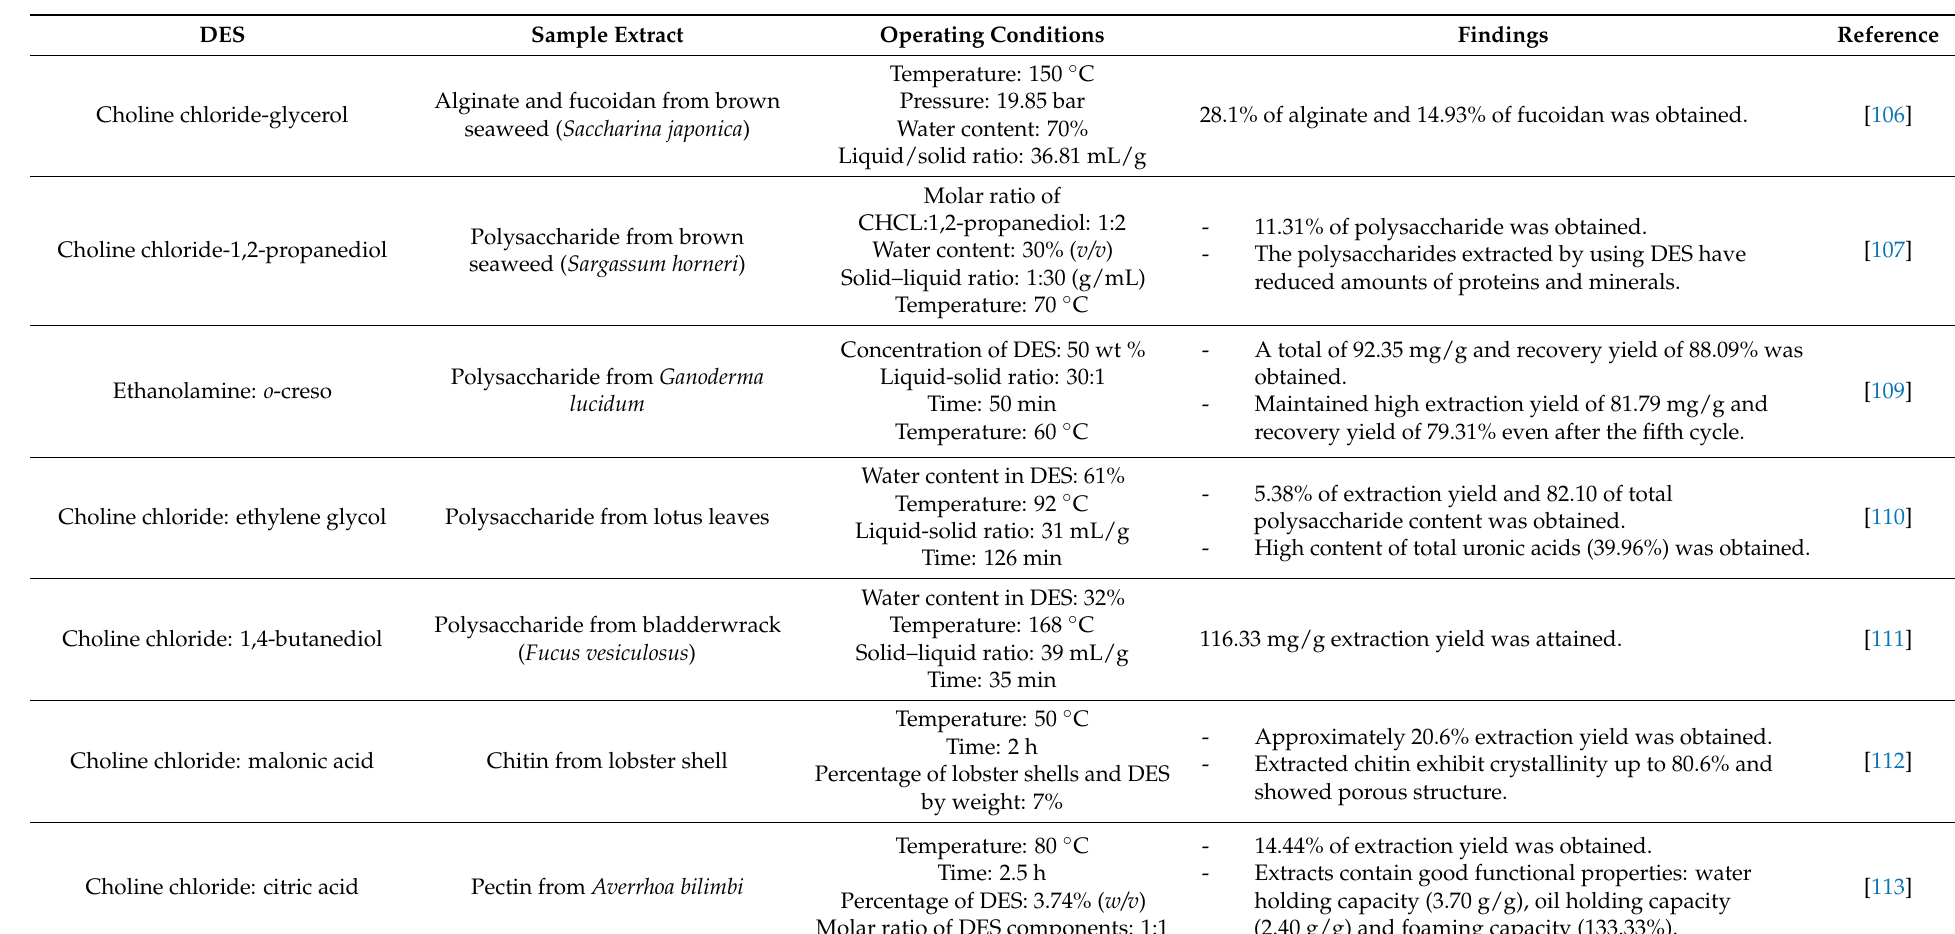
Table 3. Summary of the application of DES in extraction of